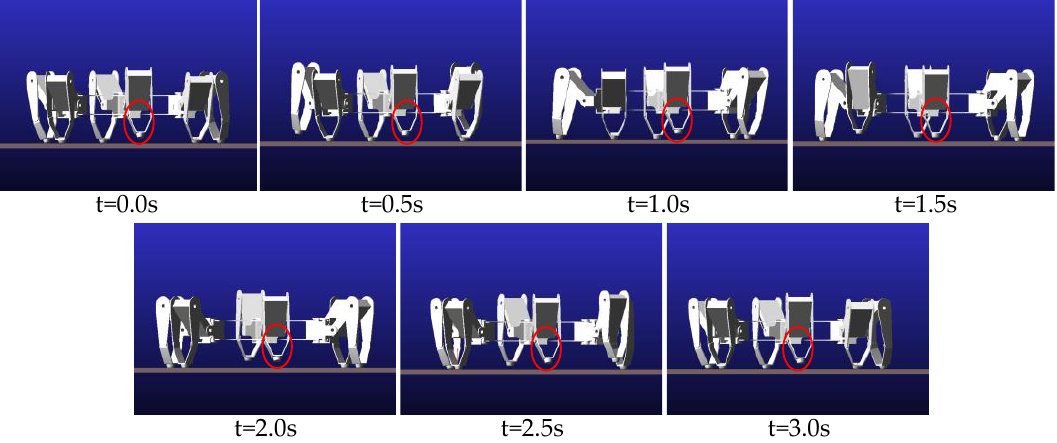
Figure 19. Lateral view of one period simulation sequence with leg 2 fault. Appl. Sci. 2020 , 10 , x FOR PEER REVIEW